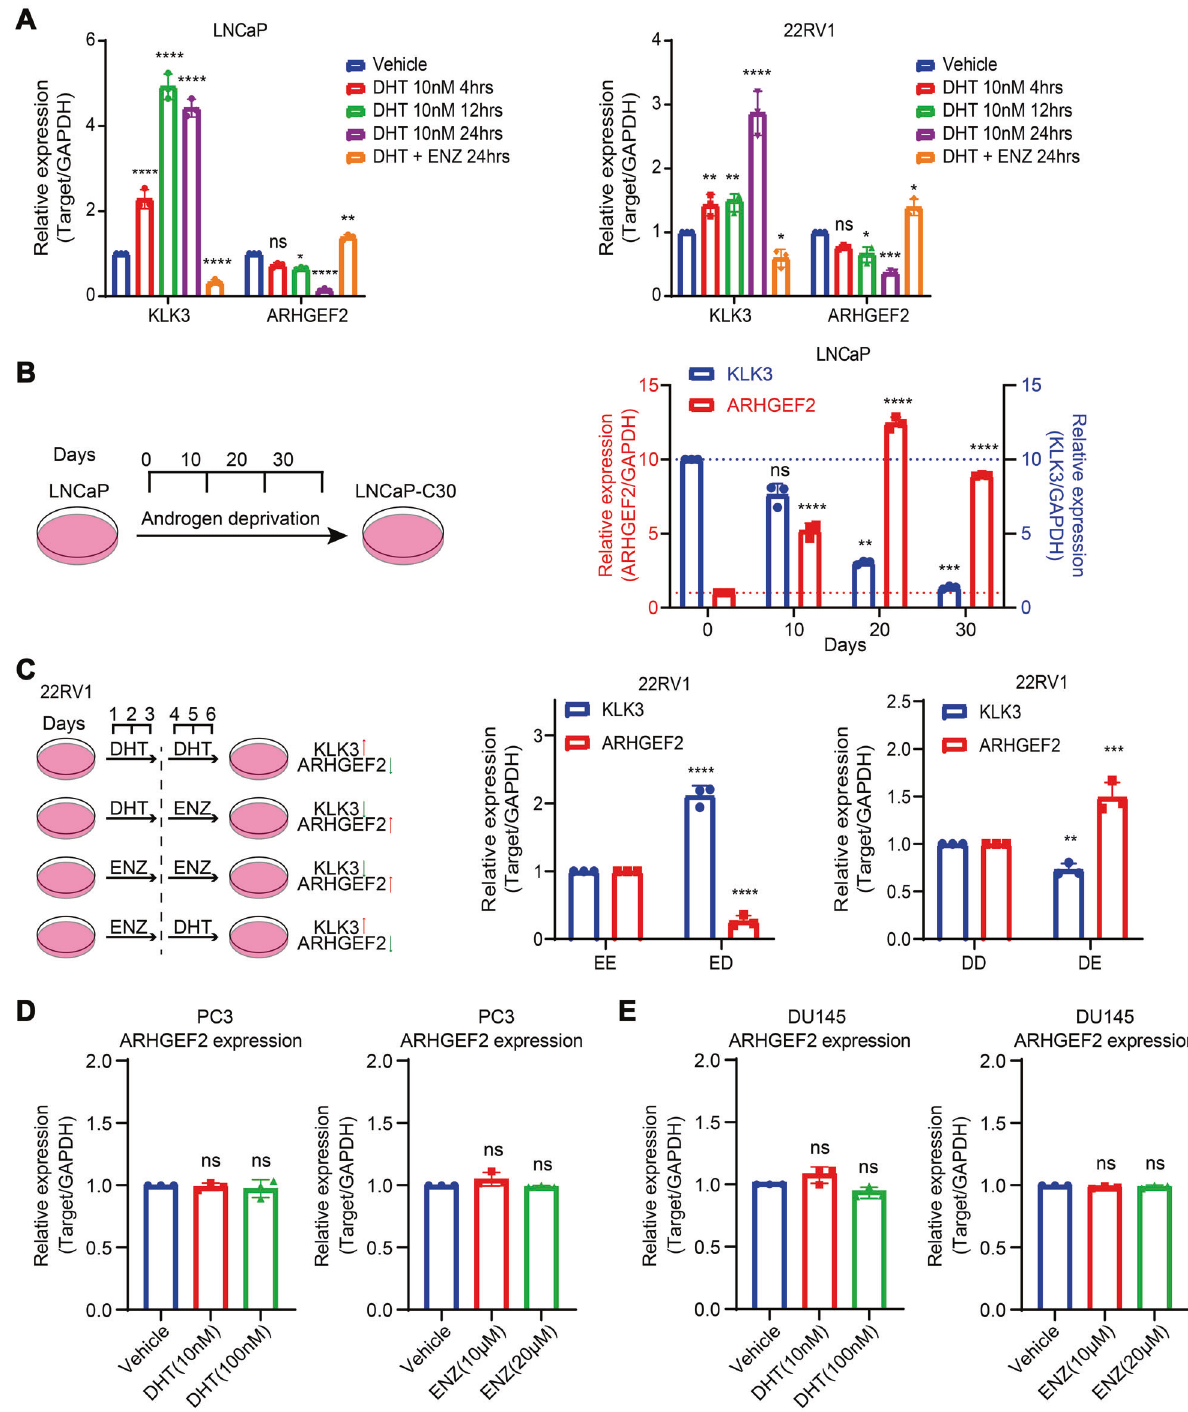
Fig. 2 ARHGEF2 expression is suppressed by AR in prostate cancer cells. A QPCR data showing the relative expression of ARHGEF2 and KLK3 in LNCaP (left) and 22RV1 (right) cells stimulated for several DHT (10 nM) treatment periods and enzalutamide. B . QPCR data showing relative expression of ARHGEF2 and KLK3 in long-term androgen deprived LNCaP cells (LNCaP-C30, LNCaP cells were cultured in androgen deprived medium for 30 days). C (Left) Schema depicting the sequential treatment of 22RV1 cells with DHT (10 nM) and enzalutamide (ENZ, 10 µM). (Right) QPCR data showing relative expression of ARHGEF2 and KLK3 using cells with sequential treatment of 22RV1 cells with DHT and/or ENZ as depicted. D QPCR data showed relative expression of ARHGEF2 using PC3 cells (an AR-negative PCa cell line) with DHT (10 nM and 100 nM) and enzalutamide (ENZ, 10 µM and 20 µM). E . QPCR data showed relative expression of ARHGEF2 using DU145 cells (an AR- negative PCa cell line) with DHT (10 nM and 100 nM) and enzalutamide (ENZ, 10 µM and 20 µM). For panels A and B , two-way ANOVA, Dunnett ’ s multiple-comparisons test; C , two-way ANOVA, Sidak ’ s multiple-comparisons test; D and E , two-tailed unpaired Student ’ s t-test was applied. Error bar indicates the standard deviation (SD). * P ≤ 0.05, ** P ≤ 0.01, *** P ≤ 0.001, **** P < 0.0001 and ns not signi fi cant.